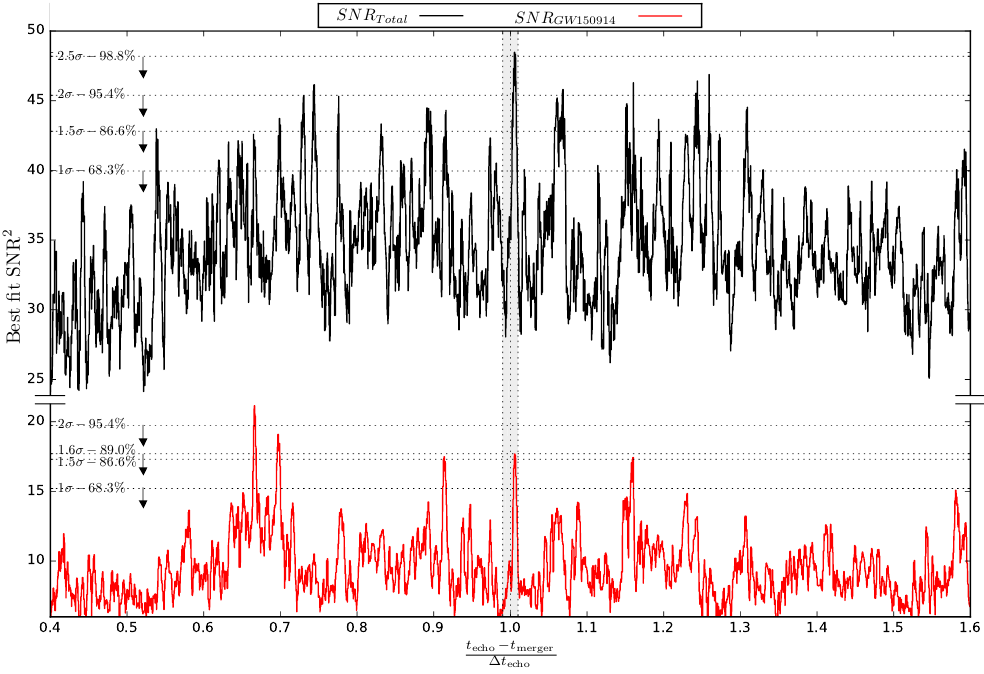
. The SNR peaks at the ∆ t echo